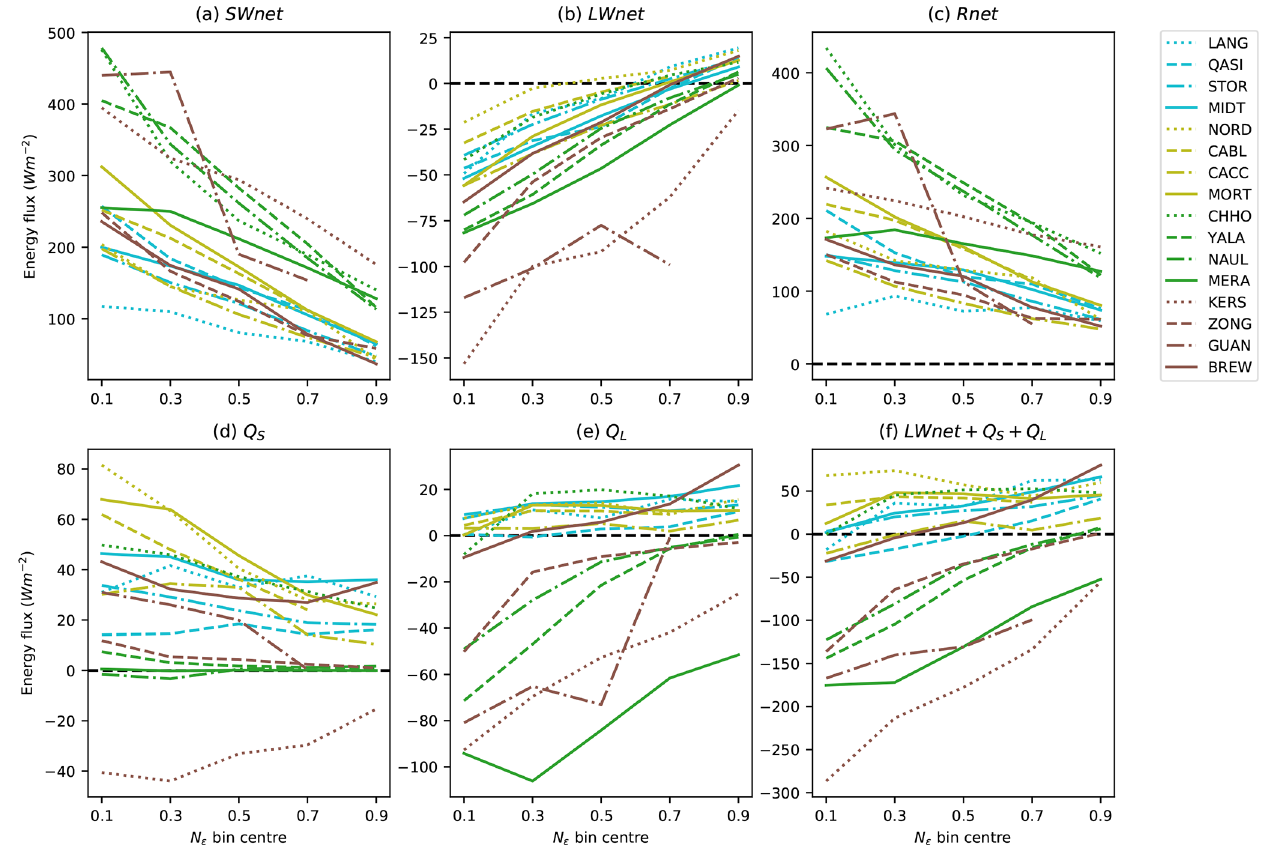
Figure A5. Average melt-season SEB terms during hours with surface melt for different cloud conditions ( N ε ).